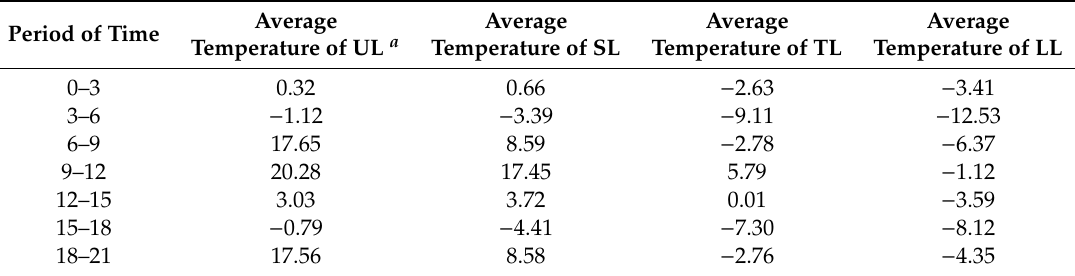
Table 1. The average temperature (°C) of four layers at each three-month interval.